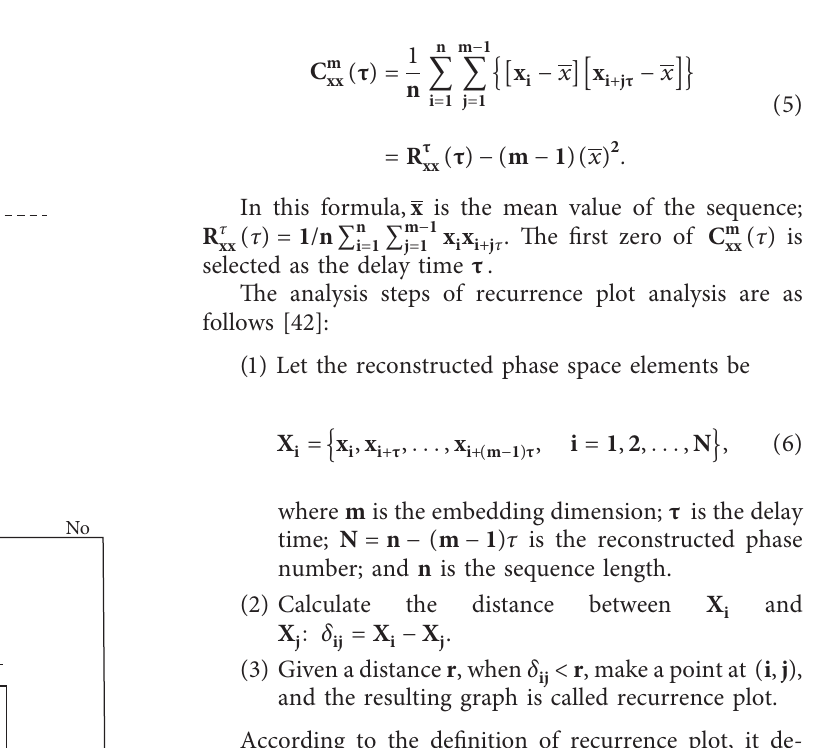
Figure 3: Measured self-heating curves of ore samples: (a) sample A; (b) sample B.